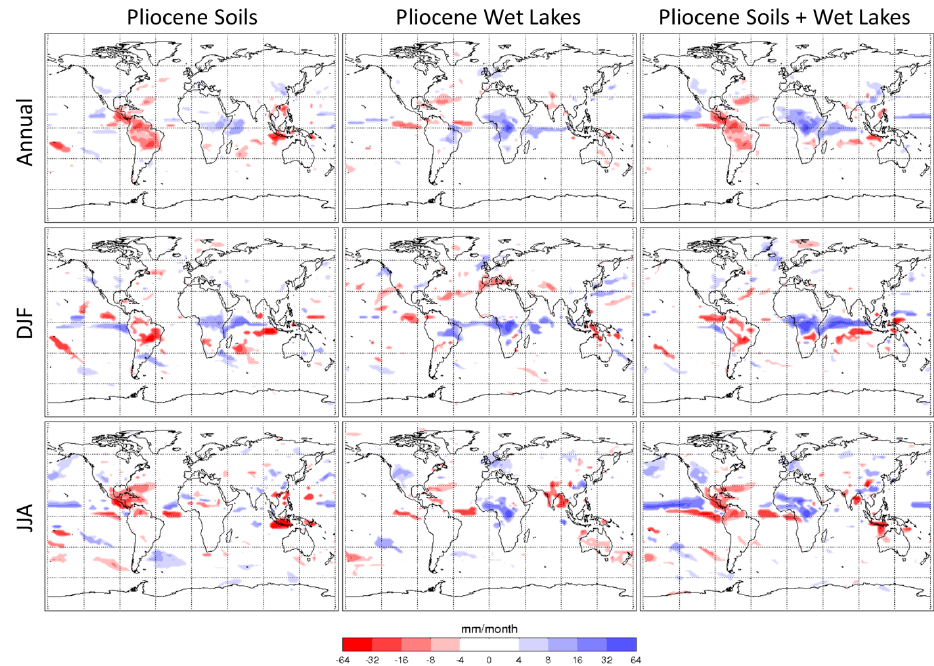
Fig. 5. Mean annual and seasonal precipitation for the soil and lake experiments. Anomalies relative to the standard PRISM3 control run Figure 5. Mean annual and seasonal precipitation for the soils and lakes experiments. 845 (with modern lake and soil distribution). Everything plotted is significant at the 0.1% confidence Anomalies relative to the standard PRISM3 control run (with modern lake and soil 846 distribution). Everything plotted is significant at the 0.1% confidence level. 847 848